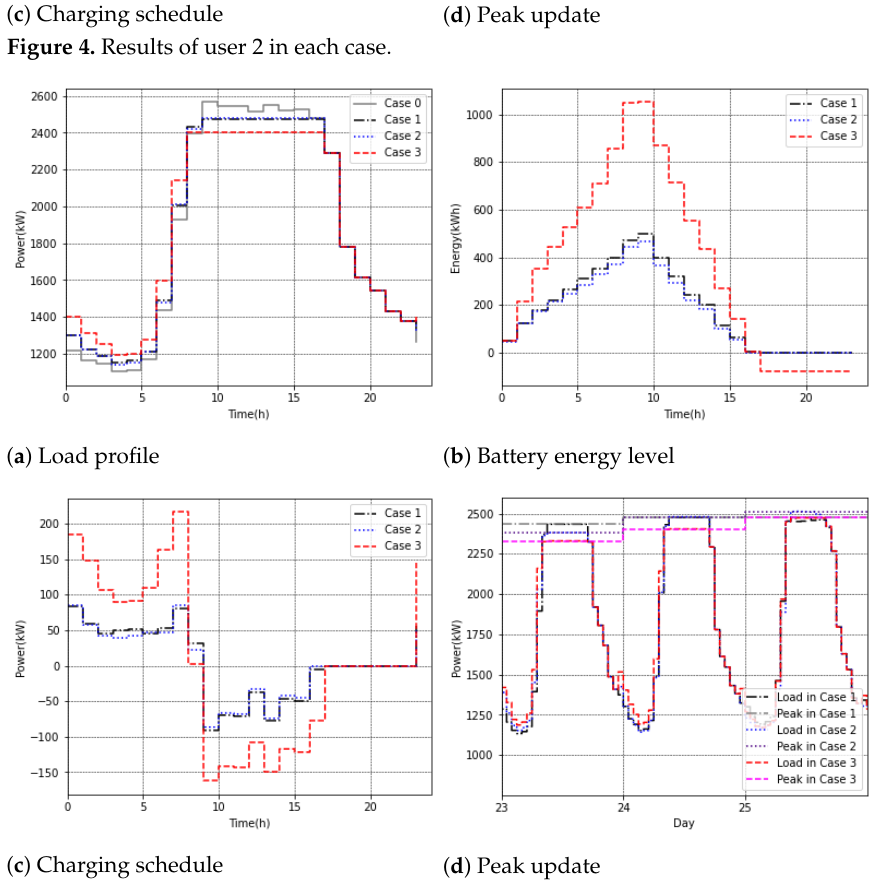
Figure 5. Results of user 3 in each